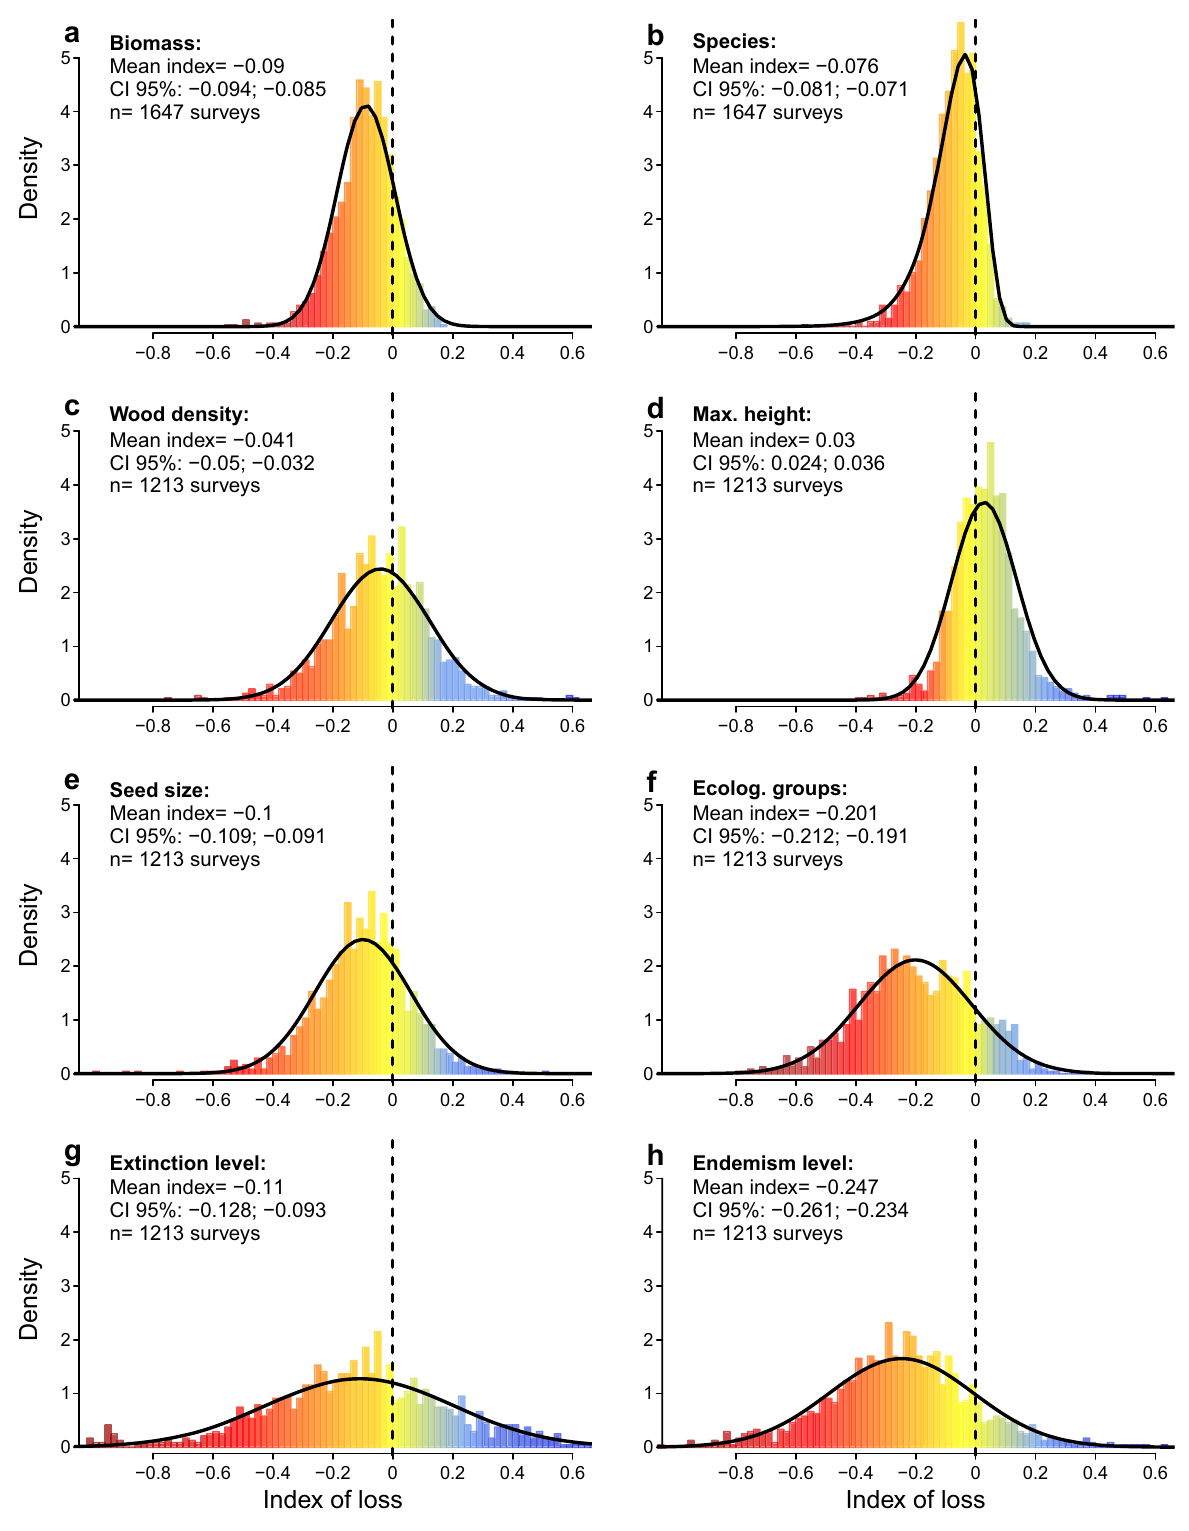
Fig. 1 The distribution of the standardized indices of biomass, species richness, and properties loss in the Atlantic Forest hotspot. Frequency distribution (coloured bars) of the index of loss for a forest biomass; b tree richness; c wood density; d maximum height; e seed mass; f ecological groups; g extinction threat; and h endemism level, with their fi ts by the Normal or Weibull distributions (solid bold lines), the estimated mean and its 95% con fi dence interval (CI). Dashed lines separate negative indices (losses due to human-related impacts) from positive ones (gains due to human-related impacts). Bars are highlighted by colours ranging from dark red (high losses) to blue (gains). The standardized index of loss is dimensionless and is highlighted by different colours ranging from dark red (high losses) to blue